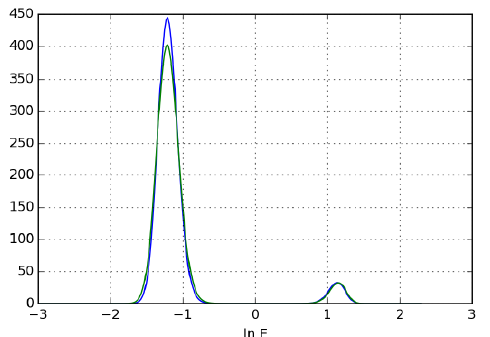
Figure 3. The distributions of adsorption energy belonging to the original (blue) and the calculated (green)